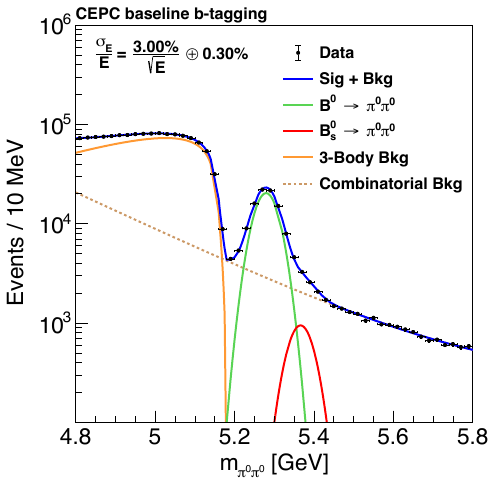
(b) Correlation between E background (right) events. Figure 5 . Simulated energy and angle distributions of π 0 pair in B 0 → π 0 π 0 , B 0 Z → q ¯ q background events.